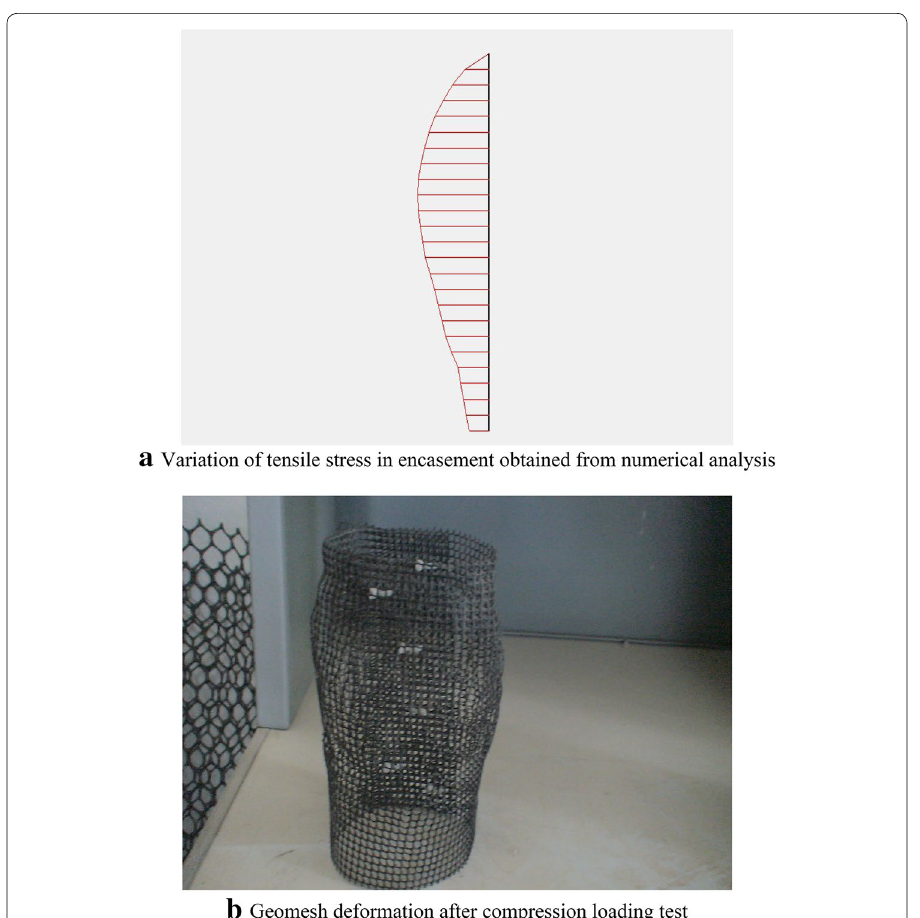
Fig. 11 Variation of tensile stresses along the length of the encasement and deformation pattern of encasement